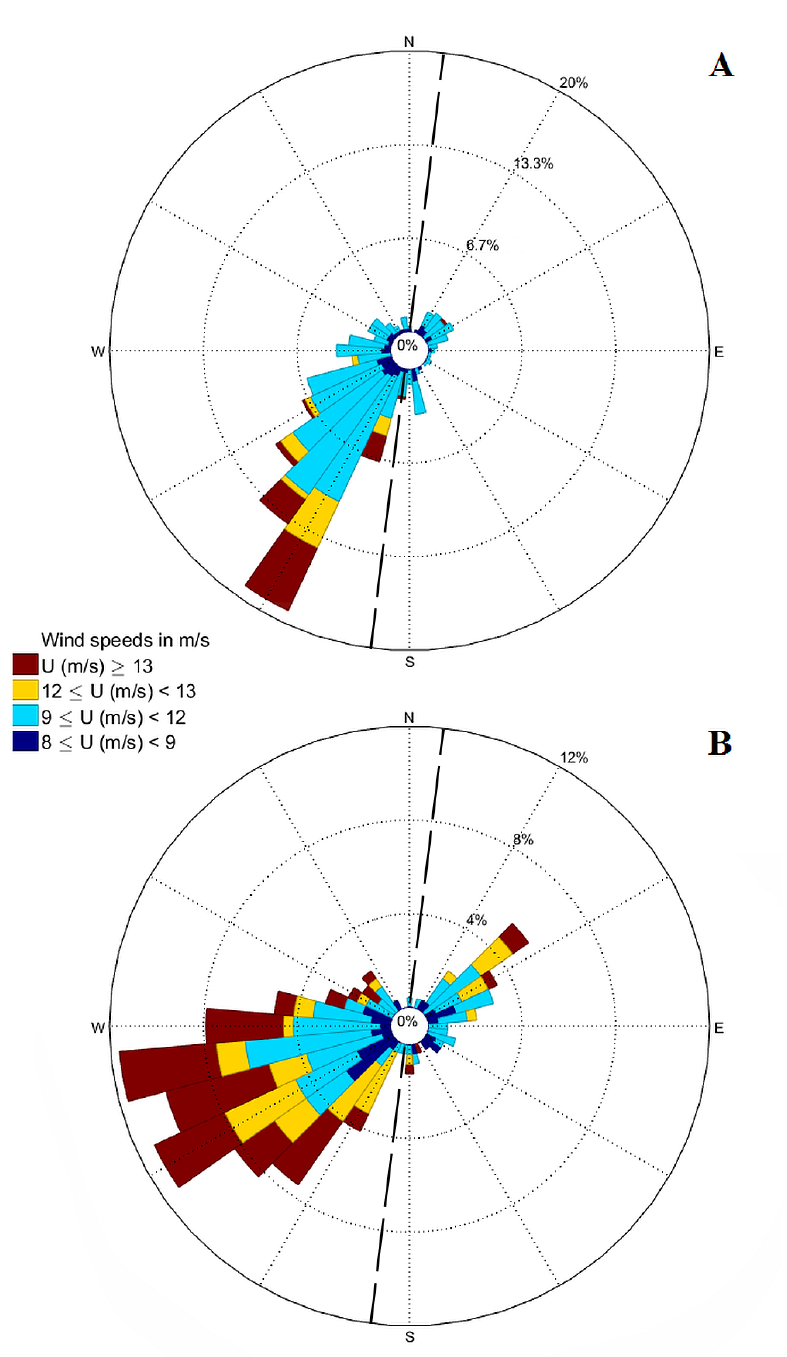
Figure 5. Wind rose for ( A ) unlimited and ( B ) limited transport events. Mind the different scales of the two wind roses. The dashed line indicates the orientation of the